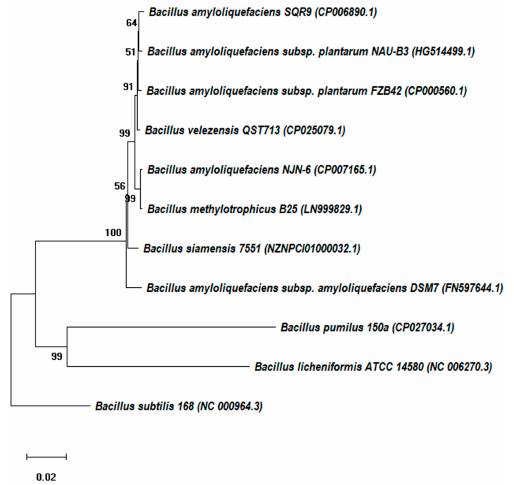
Figure 2. Phylogenetic tree constructed from the rpoB gene sequences of type strains of species from the “ B. subtilis species complex” by the neighbor-joining method (using MEGA software). Bootstrap values (%) are given at the nodes obtained by repeating the analysis 1000 times. The scale bar indicates 0.02 nucleotide substitutions per nucleotide position.